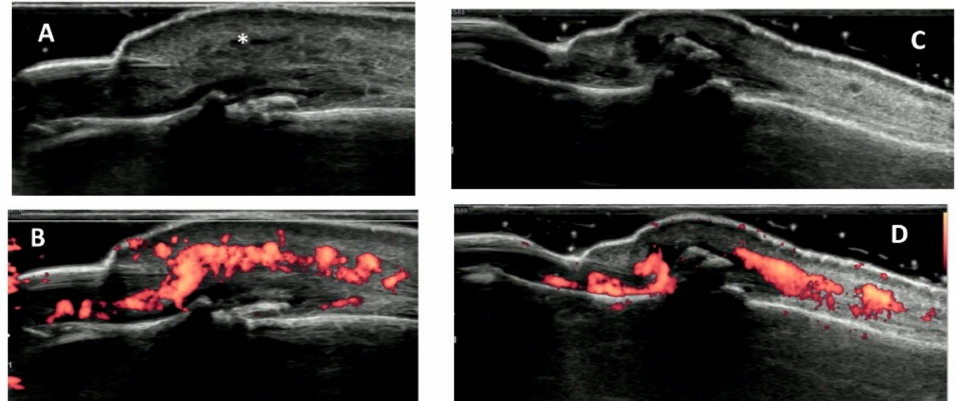
Figure 3. Ultrasound images of distal interphalangeal involvement in PsA (( A ) gray scale; ( B ) power doppler) and OA (( C ) gray scale; ( D ) power doppler). The asterix (*) highlights the soft tissue oedema surronding the extensor tendon in